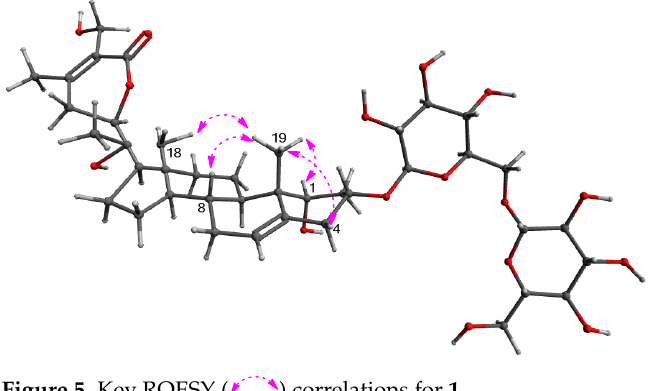
Figure 5. Key ROESY ( ) correlations for 1 .